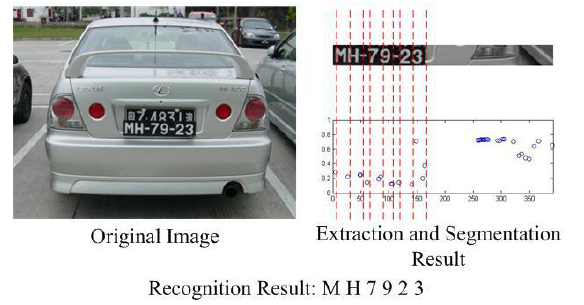
Figure 13: Experimental result with multiple license plates